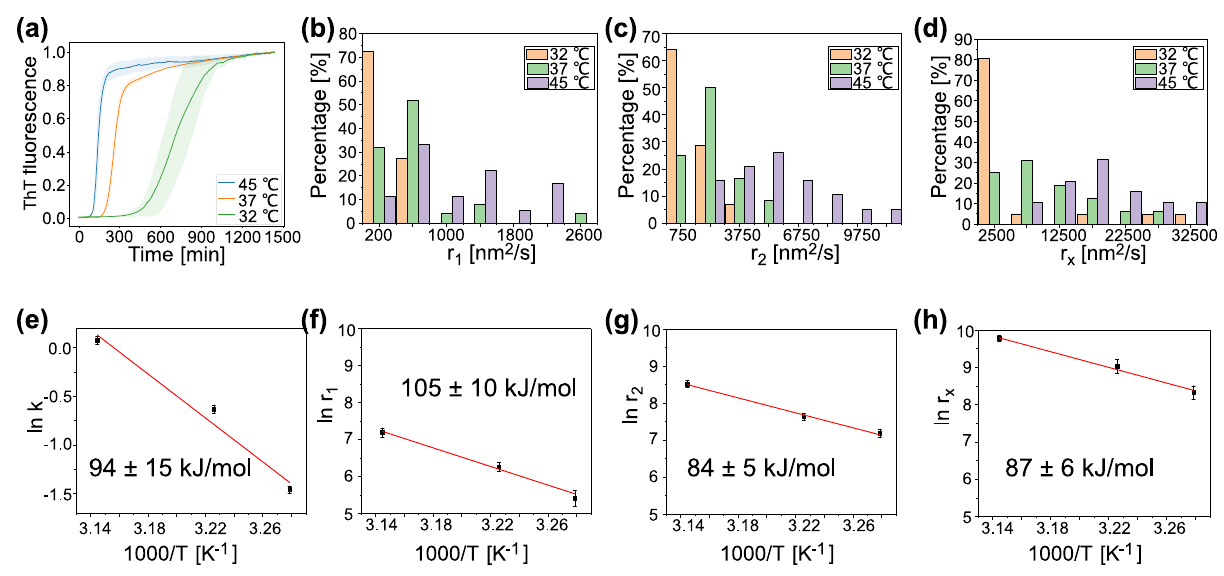
Fig. 4 Kinetic and thermodynamic characterization of insulin aggregation. a Normalized bulk ThT fl uorescence kinetics with shaded lines of standard deviation with incubation temperatures of 45, 37, and 32 °C. n = 4 for each temperature. b , c REPLOM-extracted rate distribution of anisotropic aggregates at the three different incubation temperatures: b linear part ( n = 11, 25, and 18 for 32, 37, and 45 °C, respectively) and c branching part ( n = 14, 24 and 19 for 32, 37 and 45 °C, respectively). d Rate distribution of isotropic aggregates at the three different incubation temperatures (( n = 22, 16, and 19 for 32, 37, and 45 °C, respectively)). Arrhenius plots for spherulites obtained from bulk experiments ( e ), and REPLOM ( f – h ). The error bars in e – h present standard error. The formation of linear ( f ) and branched ( g ) parts of anisotropic spherulites, and the formation of isotropic spherulites ( h ).